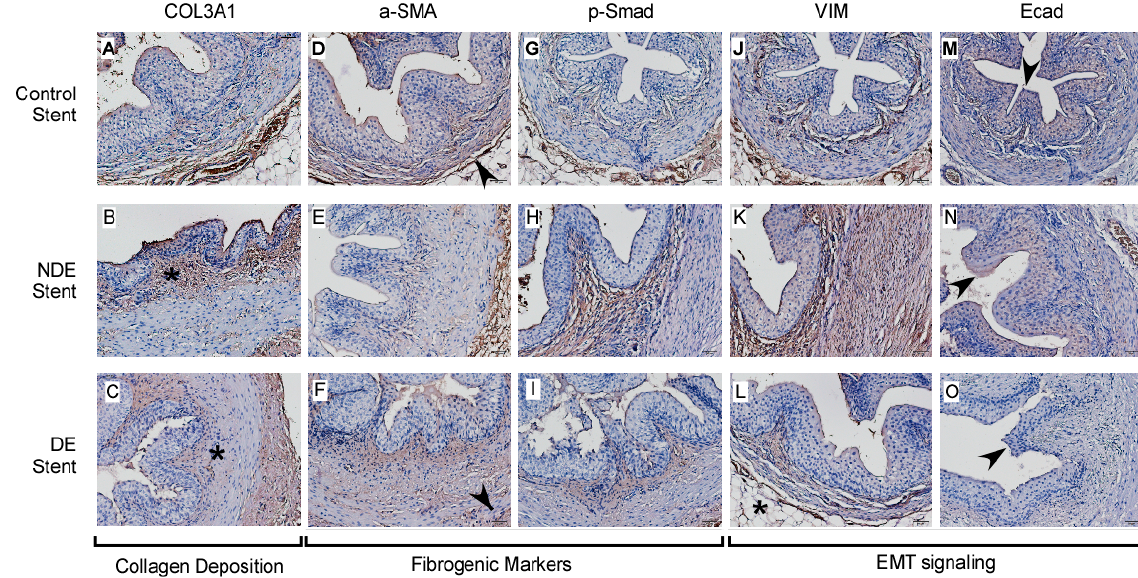
Figure 5. Ureter cross-section special stain (200× magnification) for expression of ( A – C ). collagen, ( D – F ). α -SMA, ( G – I ). p-Smad, and EMT markers including ( J – L ). Vimentin (VIM) and ( M – O ). E-cadherin (Ecad). Collagen, p-Smad, and VIM significantly increased in the thermally injured ureter (i.e.,NDE stent groups) but decreased with rapamycin treatment (i.e., DE stent groups). ( B ) Collagen COL3A1 expression increased in thermally injured ureters (asterisk). ( C ) Rapamycin eluted from DE stent result in collagen deposition decrease (asterisk). ( D – F ) α -SMA expression decreased significantly due to loss of smooth muscle and myofibroblast in injured ureters (comparing arrowhead). ( L ) Vimentin decreased when exposed to rapamycin (asterisk) comparing to ( K ). ( M – O ) E-cadherin expression is mainly localized in the urothelium (arrowheads).